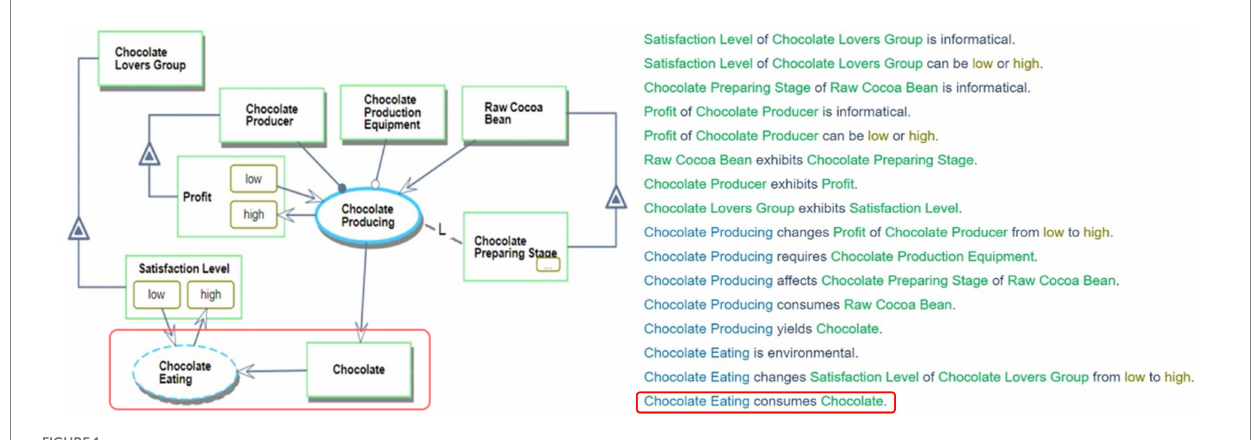
FIGURE 1 SD level OPD and its corresponding OPL of Chocolate Producing process.